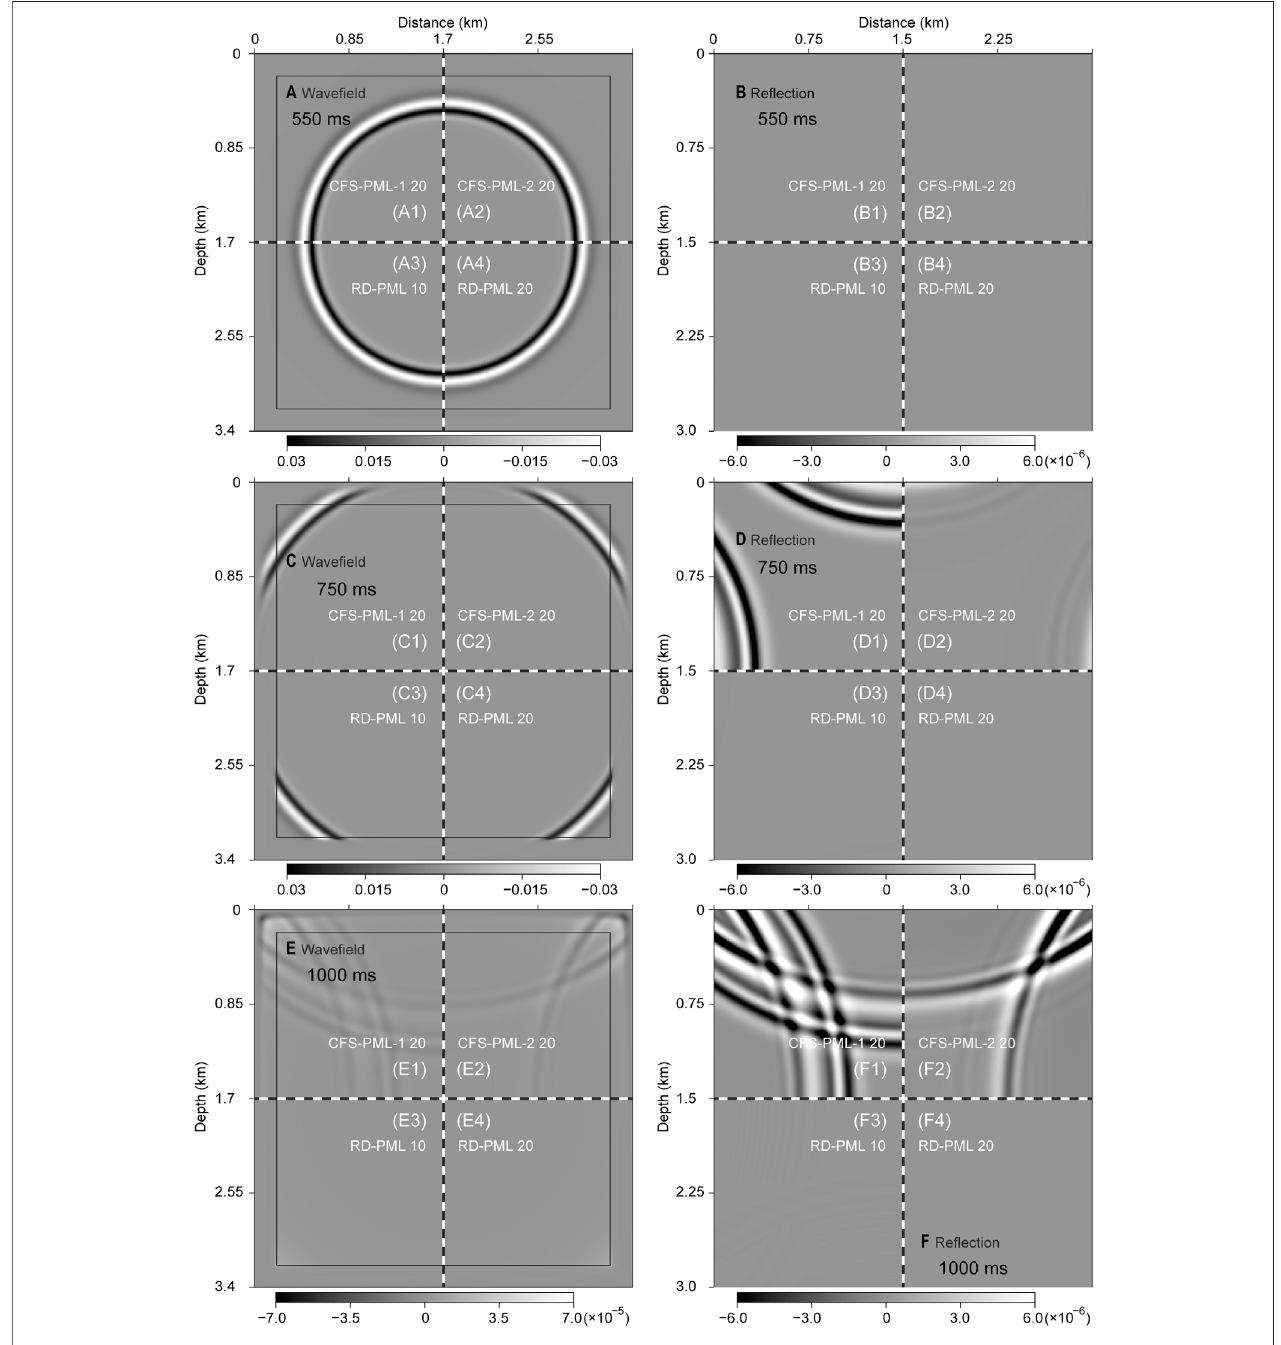
FIGURE 4 | Snapshots and wave re fl ections obtained using different types of PML. (A) , (C) , and (E) are the snapshots obtained at 550, 750, and 1,000 ms, respectively.Theareasintheblackboxesarethenormalwave fi eldsimulationarea,andtheareasoutsidetheblackboxesaretheabsorbingareaofPML. (B) , (D) ,and (F) are the wave re fl ections obtained at 550, 750, and 1,000 ms in the normal wave fi eld simulation area, respectively.